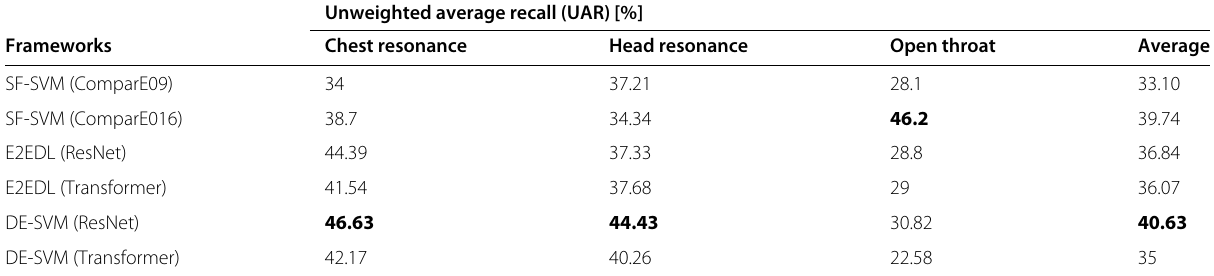
Table 4 Different frameworks’ UAR results for classification subtasks of three 4-class paralinguistic singing